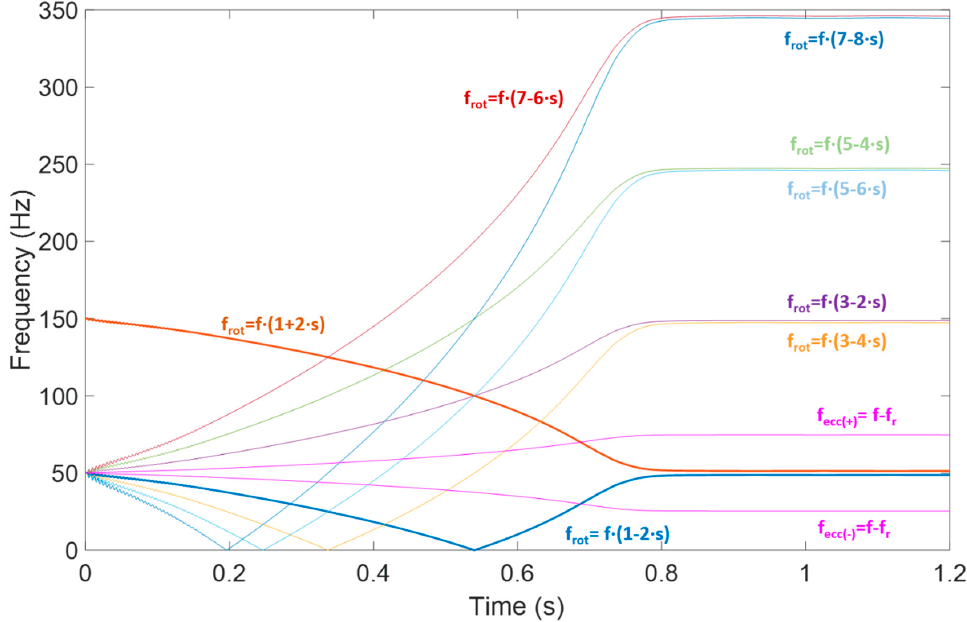
Figure 2. Theoretical evolutions of the most relevant harmonics associated to rotor damages (denoted by f rot ) and eccentricities/misalignments (denoted by f ecc ) that are present in the motor starting current, considering a simulated direct on-line starting on an induction motor.